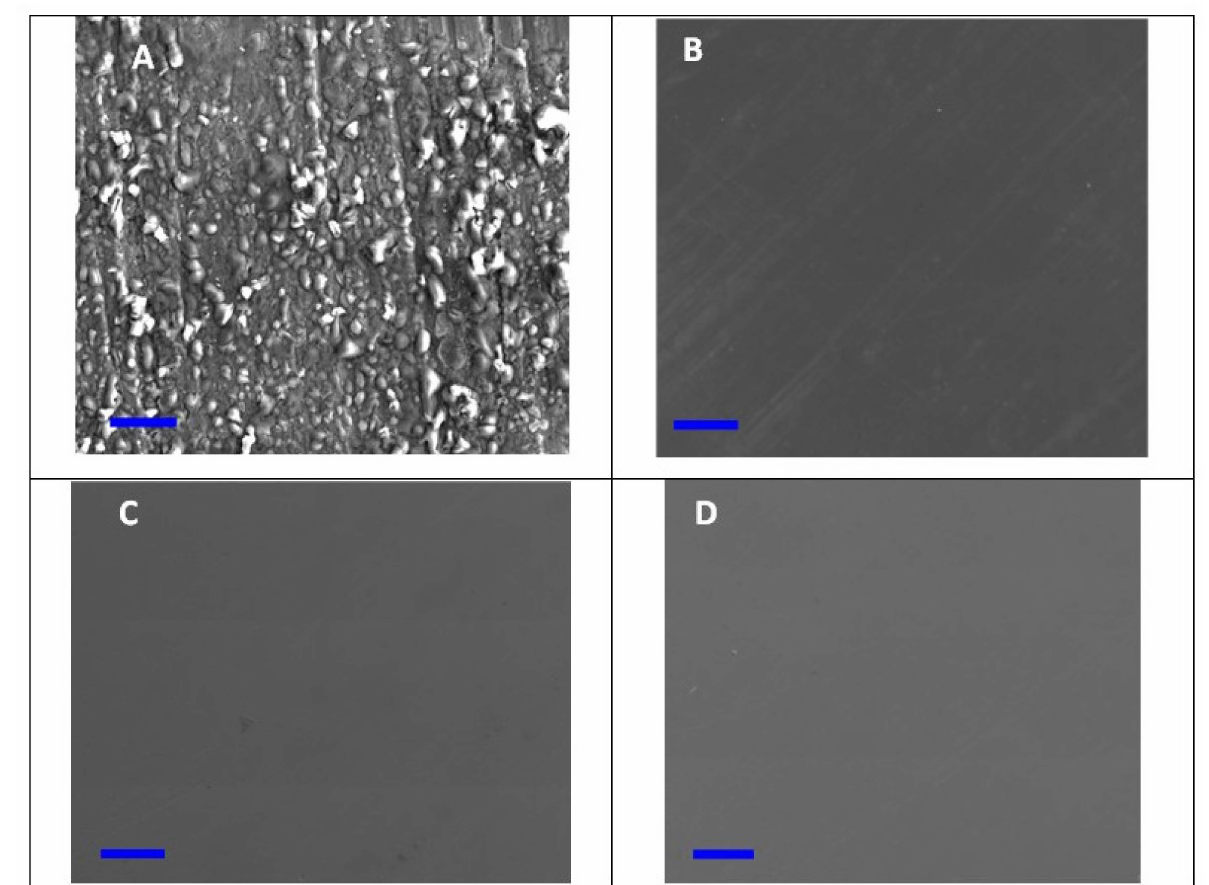
Figure 6. Scanning electron microscopy (SEM) images of the mild-steel in 1.0 M HCl alone ( A ) and containing 5 × 10 − 3 M of BMPyrIM ( B ), BMImIM ( C ) and BBMImIM ( D ) ionic liquids at 25 ◦ C for 24 h. Scale bar is 10 µ